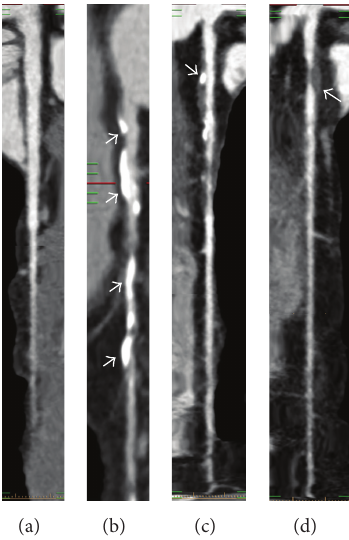
Figure 1: Representative CCTA images showing the assessed plaque subtypes. (a) Normal; (b) calcified arterial plaques; (c) mixed calcified arterial plaque; and (d) noncalcified arterial